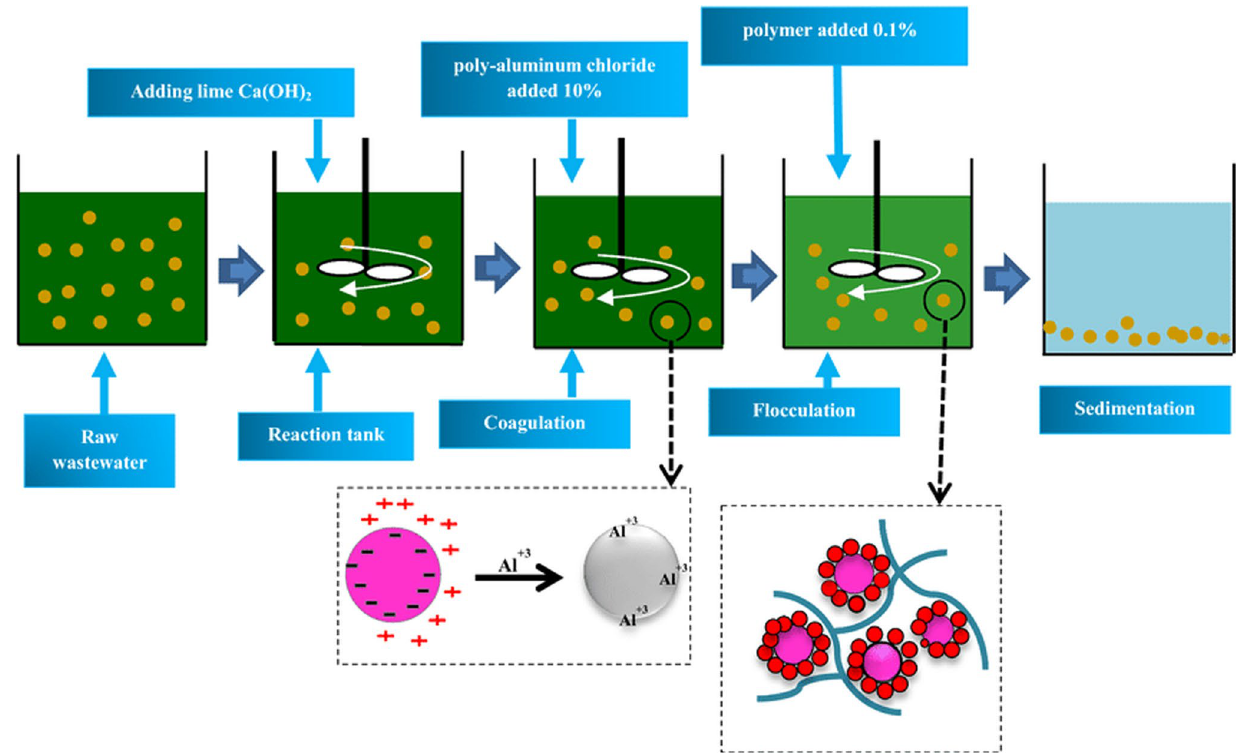
Fig. 1 Schematic diagram of the experimental